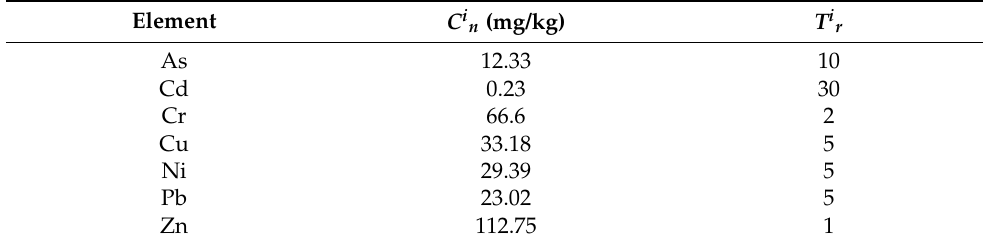
Table 1. Reference ( C i n ) and toxicity coefficient ( T i r ) for various heavy metals.